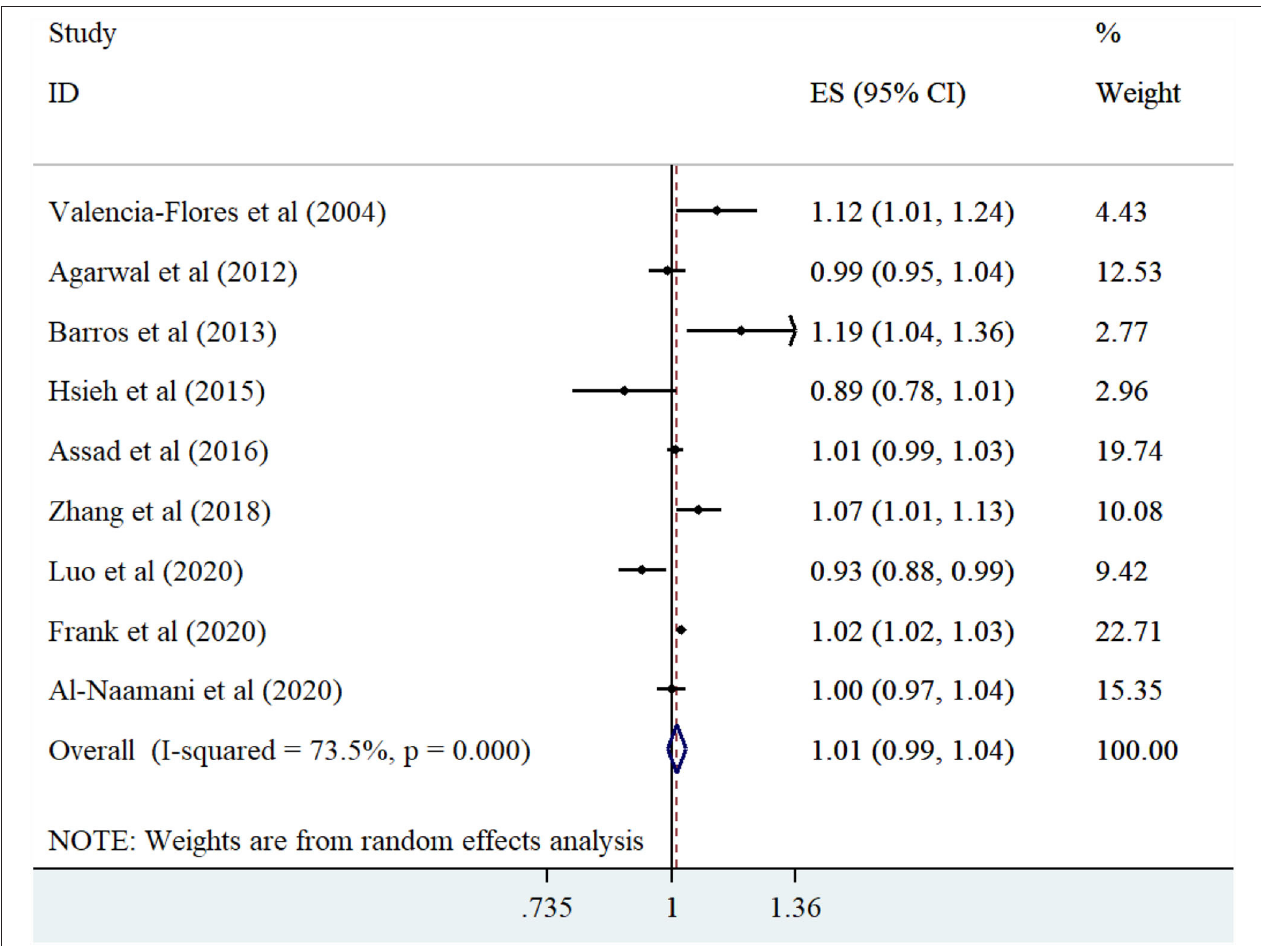
FIGURE 3 | Forest plot derived from random-effects meta-analysis of studies investigating the association between one-unit increment in BMI with pulmonary hypertension in adults. CI, confidence interval; ES, effect